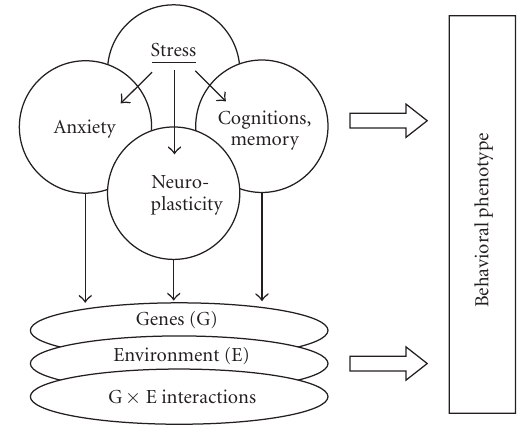
Figure 1: Stress, memory, and anxiety